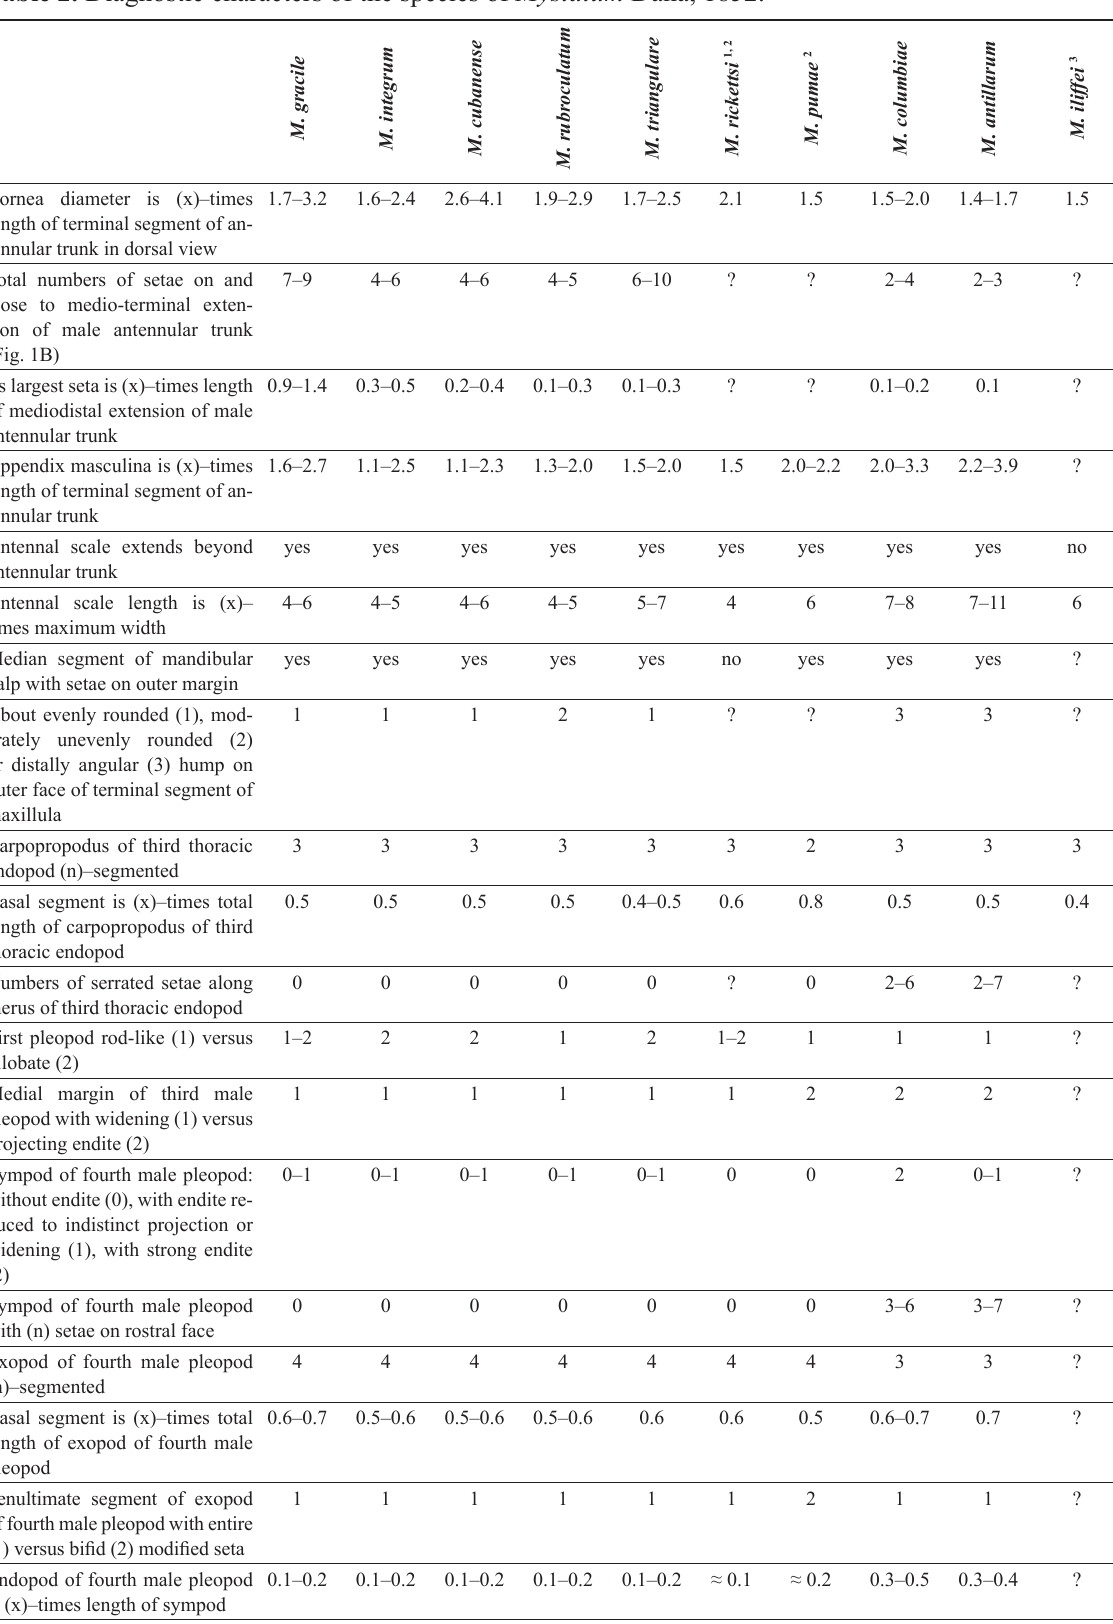
European Journal of Taxonomy 495: 1–48 Table 2. Diagnostic characters of the species of Mysidium Dana, 1852.